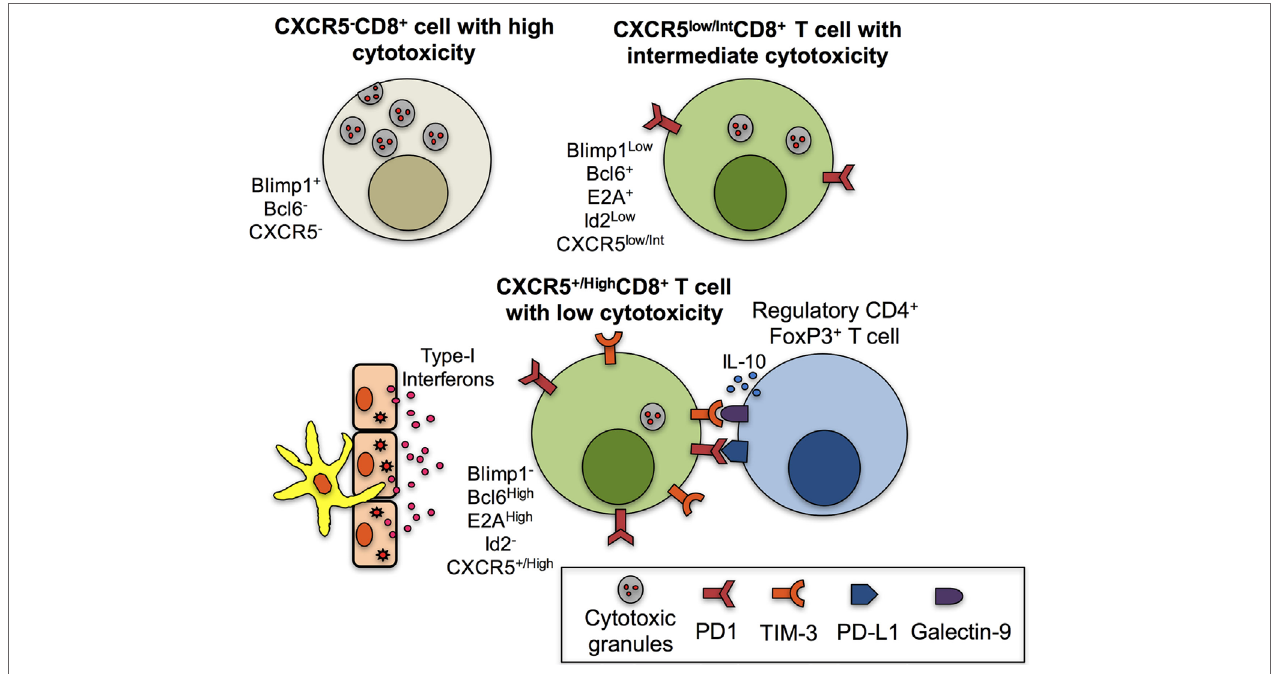
FigURe 2 | Mechanisms associated with the low cytotoxic function of CXCR5 + CD8 + T cells. CXCR5 − CD8 + T cells are characterized by high levels of cytotoxic granules due to, among other factors, the expression of Blimp1 and the absence of B cell lymphoma 6 protein (Bcl6). CXCR5 low/int CD8 + T cells have decreased cytotoxic functions due to the expression of Bcl6, E2A, and low Blimp1 and Id2 and possibly to the expression of PD-1. However, fully differentiated CXCR5 + / High CD8 + T cells have high expression of Bcl6 and E2A and lack of Blimp1 and Id2. In addition, in the context of chronic infection in the lymphoid follicle and antigenic persistence, the paracrine or endocrine production of type-I interferons (IFNs) by antigen-presenting cells or epithelial cells contributes to the high expression of programmed death (PD)-1 and possibly T-cell immunoglobulin and mucin-domain containing (TIM)-3, which bind to their ligands PD-L1 and galectin-9, respectively, expressed in regulatory CD4 + T cells; the IL-10 production by regulatory T cells also contributes to the low cytotoxic abilities of CXCR5 + /High CD8 + T